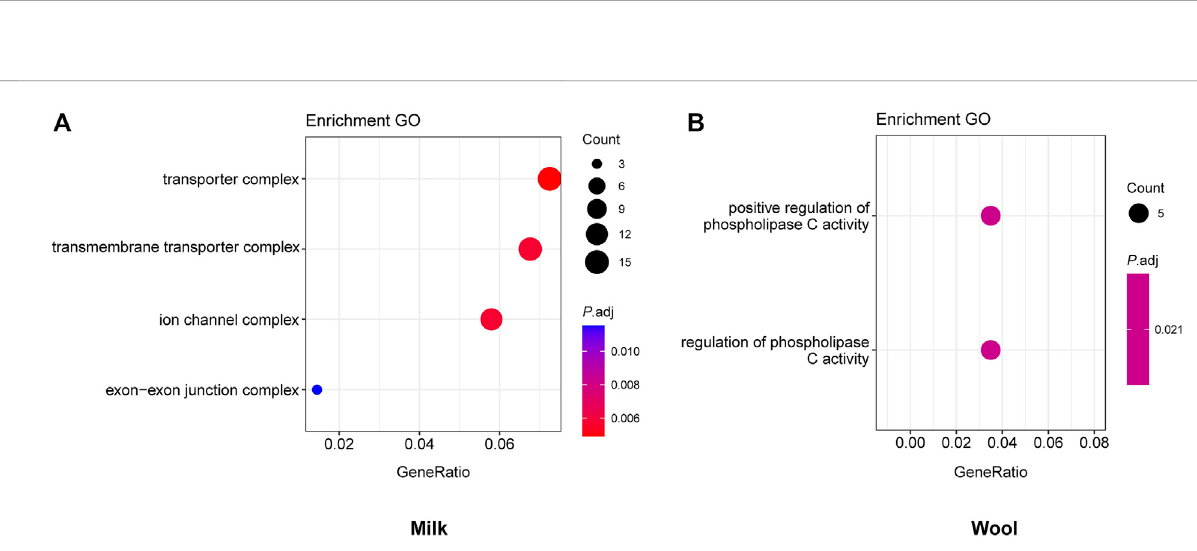
FIGURE 3 GO enrichment analyses for milk (A) and wool (B) , with the signi fi cant ( p .adj < 0.05) GO